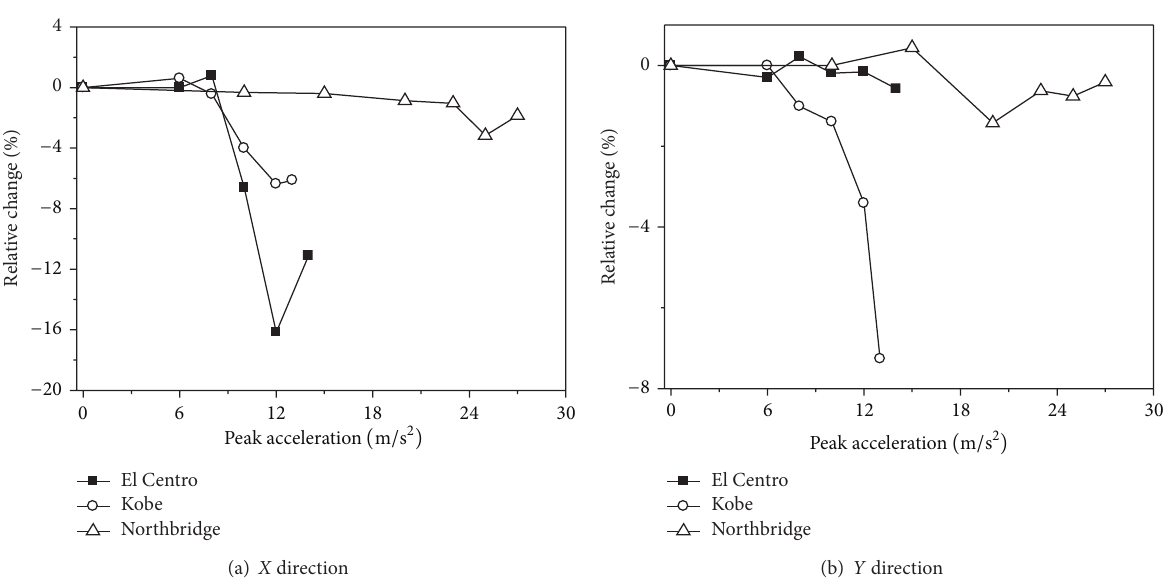
Figure 4: Relative changes of the maximum top displacements of 2nd transmission